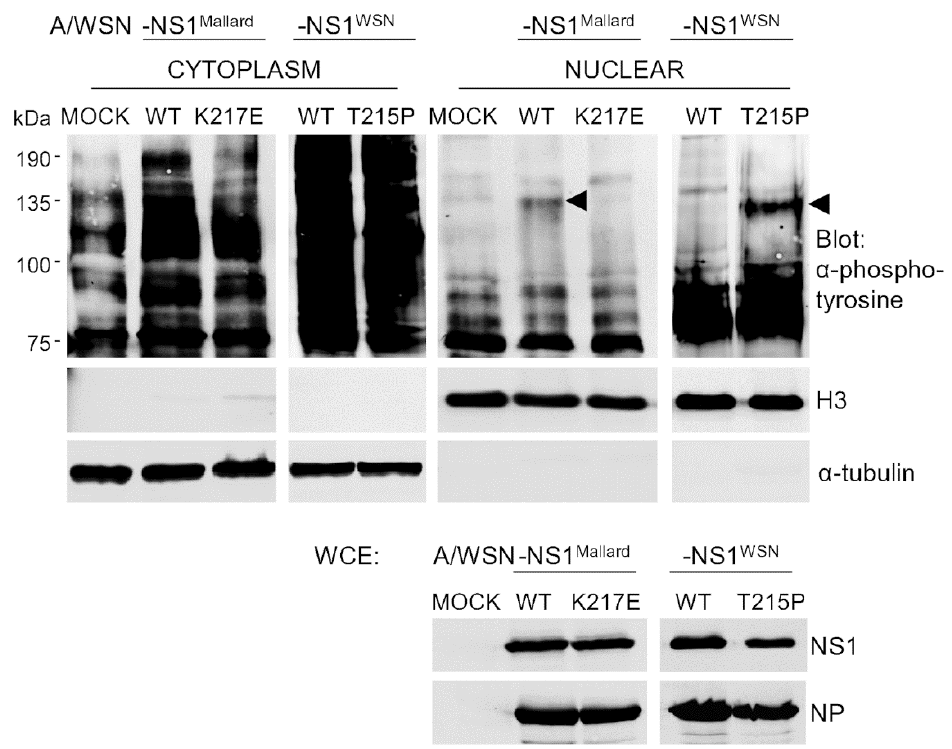
Figure 5. Nuclear targeting of Crk by NS1 causes a change in the nuclear protein tyrosine phosphorylation pattern of IAV-infected cells. A549 cells were infected with recombinant viruses as indicated for 24 h at a MOI 2, and treated with pervanadate for 10 min before cytoplasmic ( C ) and nuclear ( N ) extracts were prepared. The extracts were probed with an anti-phosphotyrosine antibody. As in Figure 3, shown are also H3 and α-tubulin blots to verify the quality of the subcellular fractionation, as well as blotting of whole cell extracts (WCE) with antibodies for NS1 and NP to verify equal NS1 expression of NS1 and uniform infection of cells with the different viruses.